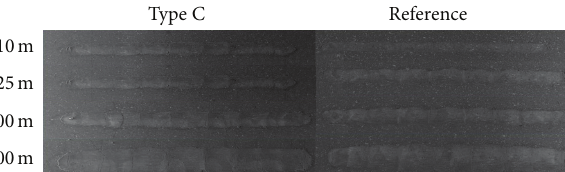
Figure 10: SEM images of worn patterns at 500 m sliding distance.